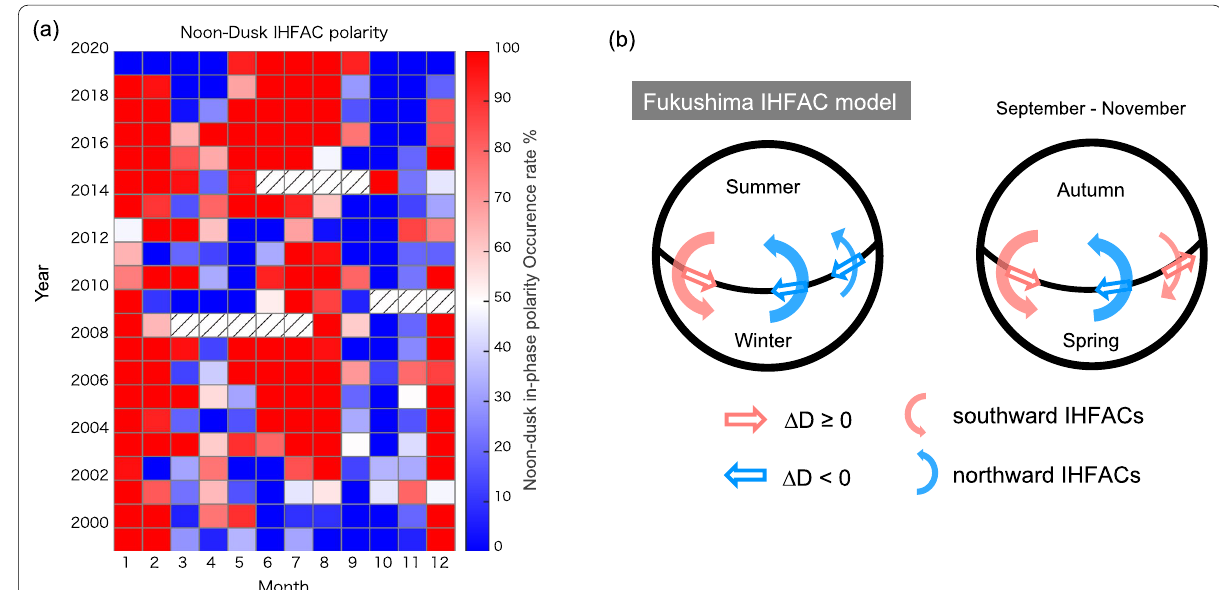
Fig. 2 Distribution of the dusk-side IHFAC of the Fukushima’s model type from 1999 to 2019. a The occurrence rate of the dusk-side IHFAC of the Fukushima’s model type as a function of month and year. The red color indicates higher occurrence of the dusk-side IHFAC of the Fukushima’s model type, which means the in-phase IHFAC polarity in both noon and dusk sectors. The blue color represents lower occurrence rate, this is equal to higher occurrences of the dusk-side IHFAC, which disagreed with the concept of Fukushima’s model. The hatched areas show the no-data periods. b The illustration of IHFACs polarity. The left side describes the concept of Fukushima’s model for the northern hemisphere in summer. The right side shows the opposite dusk-side IHFAC of the Fukushima’s model